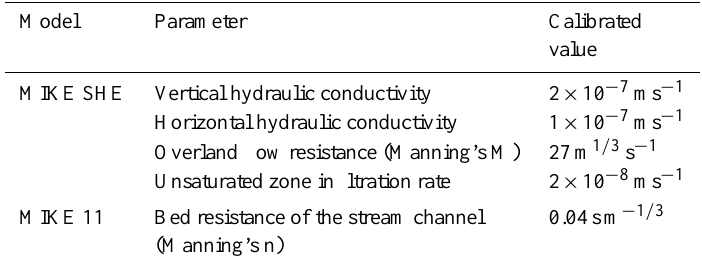
Table 2. Calibrated MIKE SHE parameters